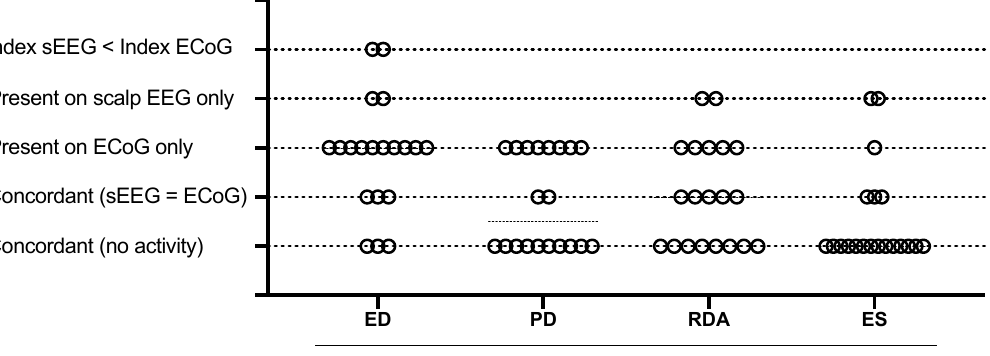
Figure 2. Interictal spikes in a patient 1 day after TBI. High-amplitude spikes are evident on ECoGs (L3–L4 electrodes on the strip) but not in scalp EEG. A typical example, patient #7.